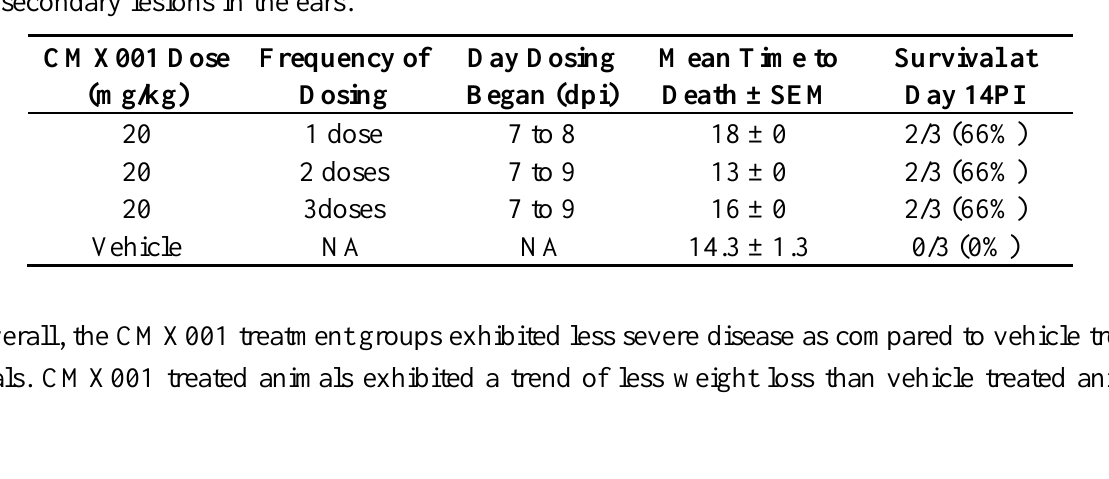
Table 3. Evaluation of efficacy in natural aerosol infected animals. Groups of 3 animals were treated with CMX001 1, 2 or 3 times every other day beginning at the appearance of secondary lesions in the